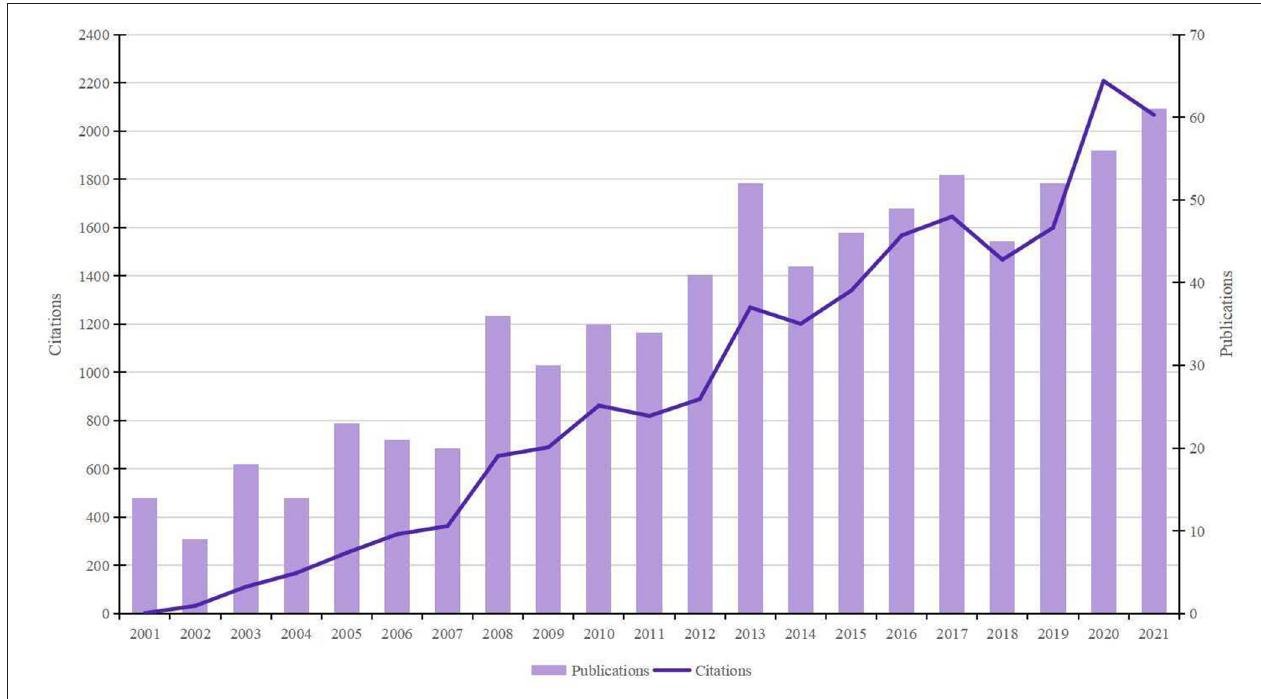
FIGURE 1 | Trends of BHD publications over the past 20 years.